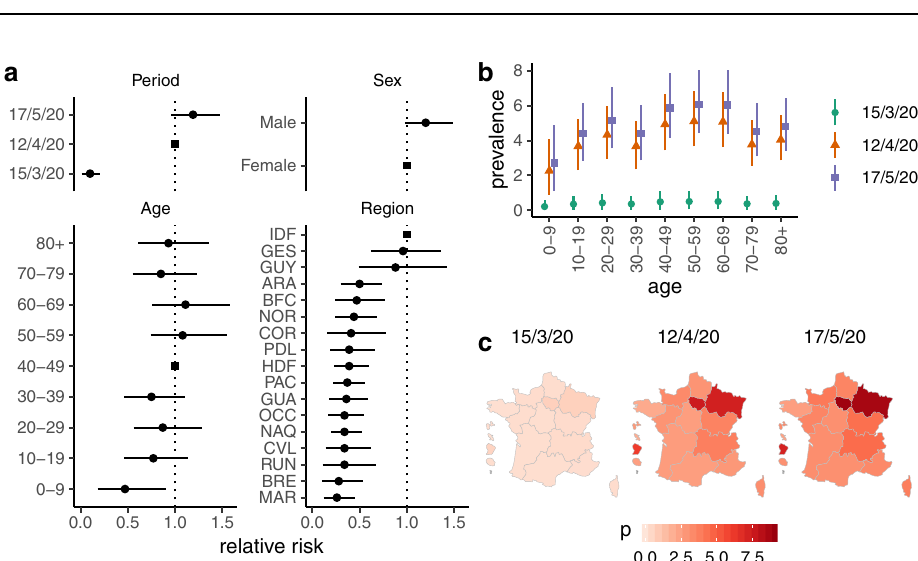
Fig. 1 Prevalence of SARS-CoV-2 antibodies in France. a Estimated relative risks of seroprevalence by collection period, sex, age and region. Dots represent mean relative risk and bars 95% uncertainty interval of relative risk estimate over 10 4 iterations. Reference categories are indicated by a square. Collection periods are indicated by last day of each week (9 – 15 March 2020, 6 – 12 April 2020 and 11 – 17 May 2020). Regions: GUA Guadeloupe, MAR